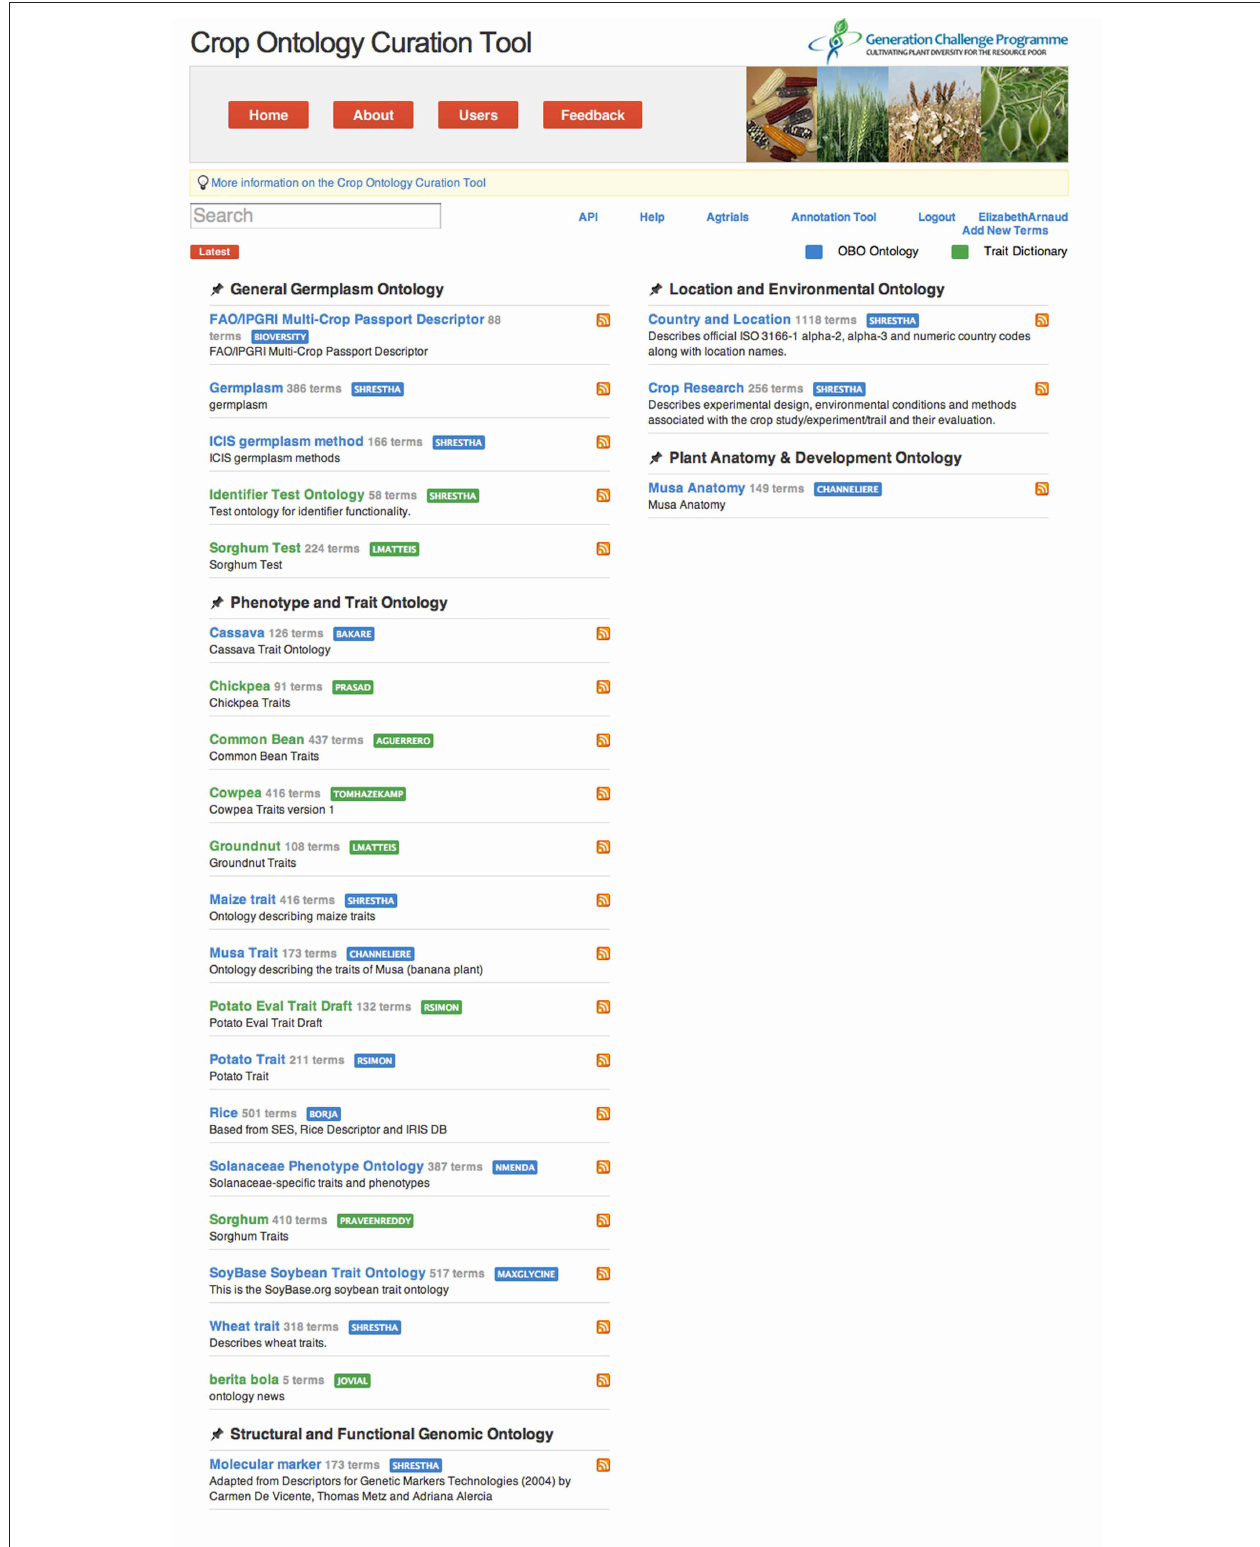
FIGURE 5 | Crop Ontology homepage (http://www.cropontology.org).